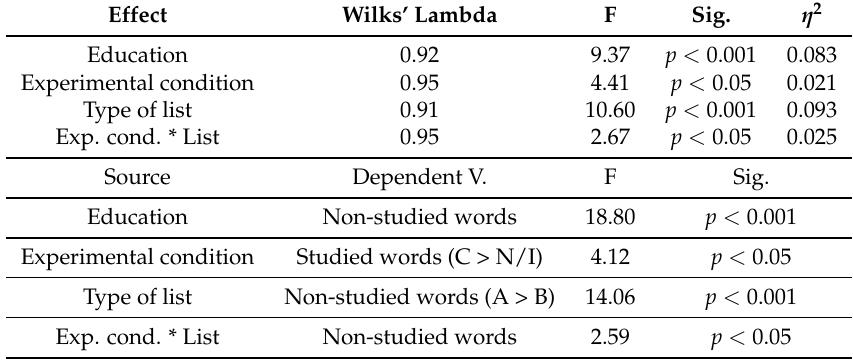
Table 3. MANCOVA on the subjects’ performance. The letters “C”, “N”, “I” mean, respectively, the collaborative, nominal and individual experimental conditions. The letters “A” and “B” refer to the type of list, respectively the list of abstract words (feelings) and the list of concrete words (musical instruments). The model explains the 16% of the variance ( r 2 = 0.159). * indicates the combined